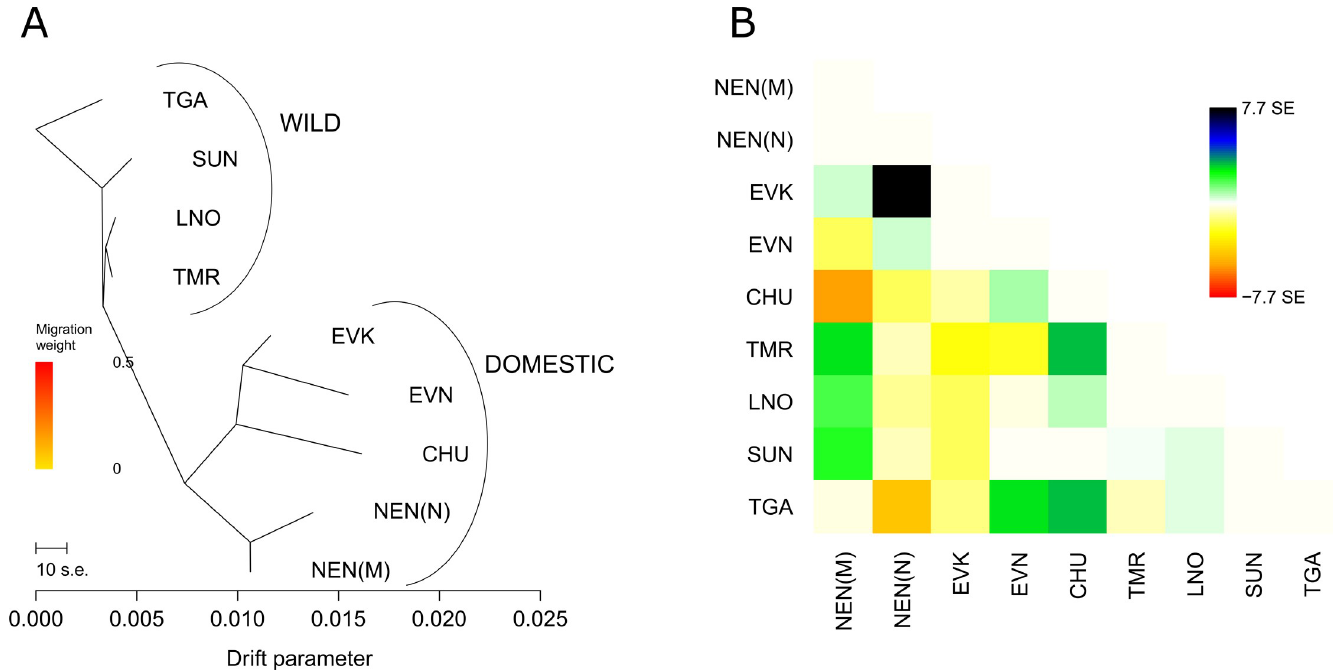
Fig 5. A. Maximum likelihood tree of all studied reindeer groups with no migration events based on 8357 SNPs. B. The residual plot, corresponding to the tree with no migration events based on 8357 SNPs. Note: NEN_M–Nenets breed of the Murmansk region; NEN_N–Nenets breed of the Nenets Autonomous district; EVK–Evenk breed, EVN–Even breed; CHU–Chukotka-Khargin breed; TMR–Taymyr Peninsula, LNO–Leno-Olenek, SUN–Sundrun, and TGA–taiga (boreal forest) wild populations. Colors are described in the palette on the right.